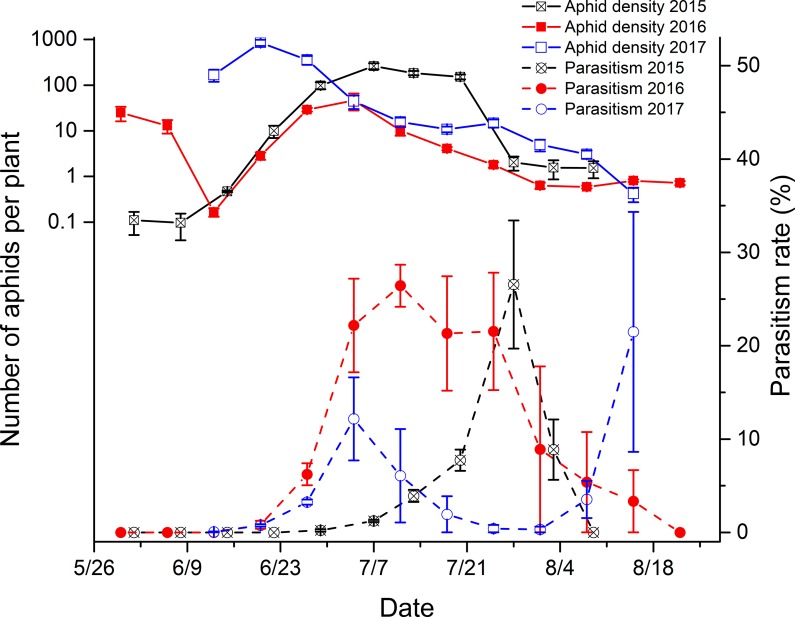
Population dynamics of cotton aphids and their level of parasitism in Korla, China (2015–2017).The data in the figures were shown as the mean ± SE.